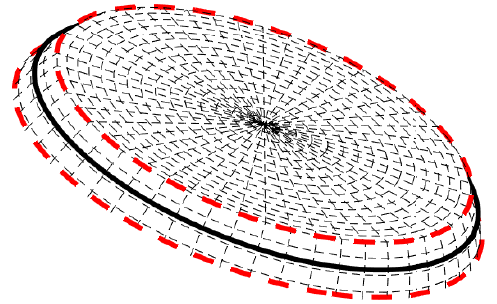
Figure 15. Spherical segment defined by the lower and higher critical circles (red). The black circle is the common secondary